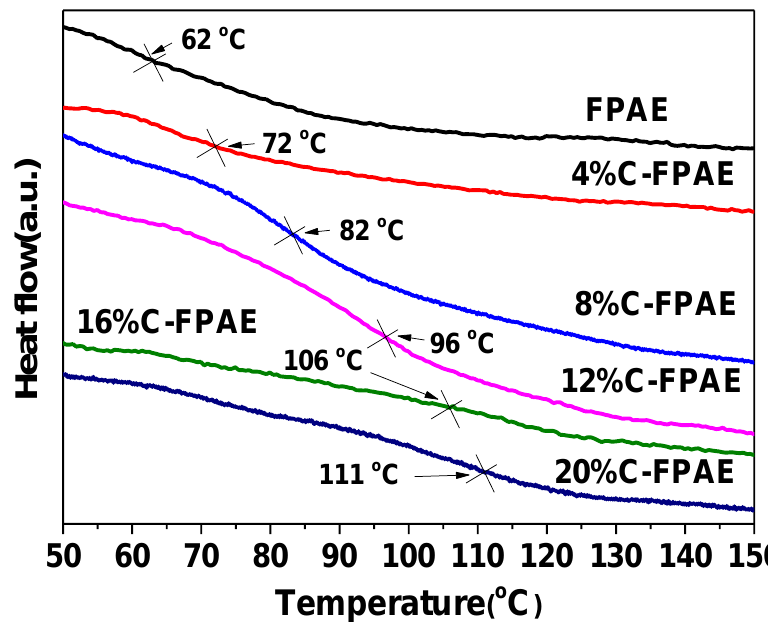
Figure 6. DSC curves of FPAE and C-FPAE series.